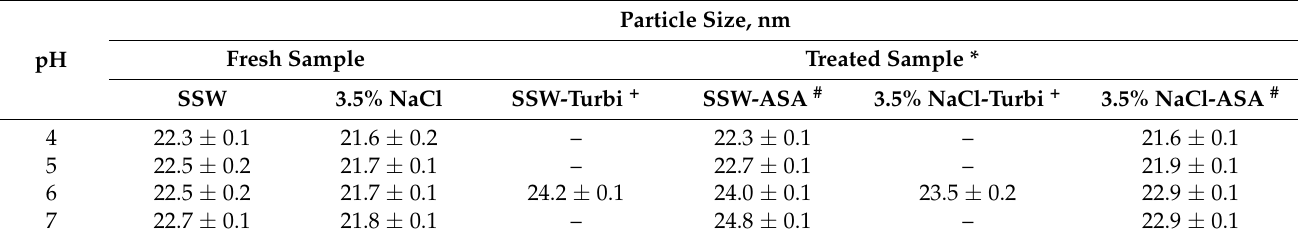
Table 3. Dynamic light scattering (DLS) size measurements of 1 wt% OF50-M in synthetic seawater (SSW) and 3.5% NaCl brine when fresh and after turbidity scan and accelerated stability analysis